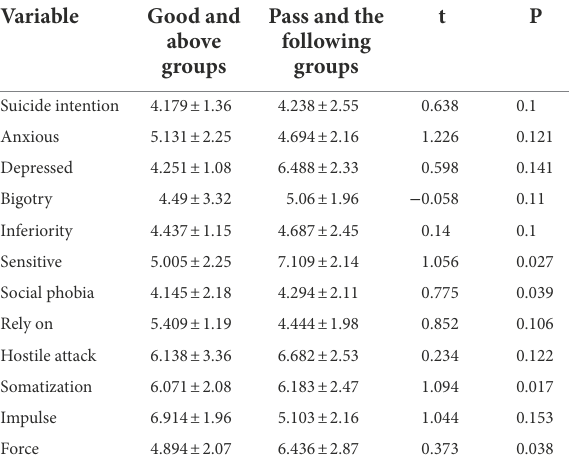
TABLE 3 T-test analysis of various psychological test